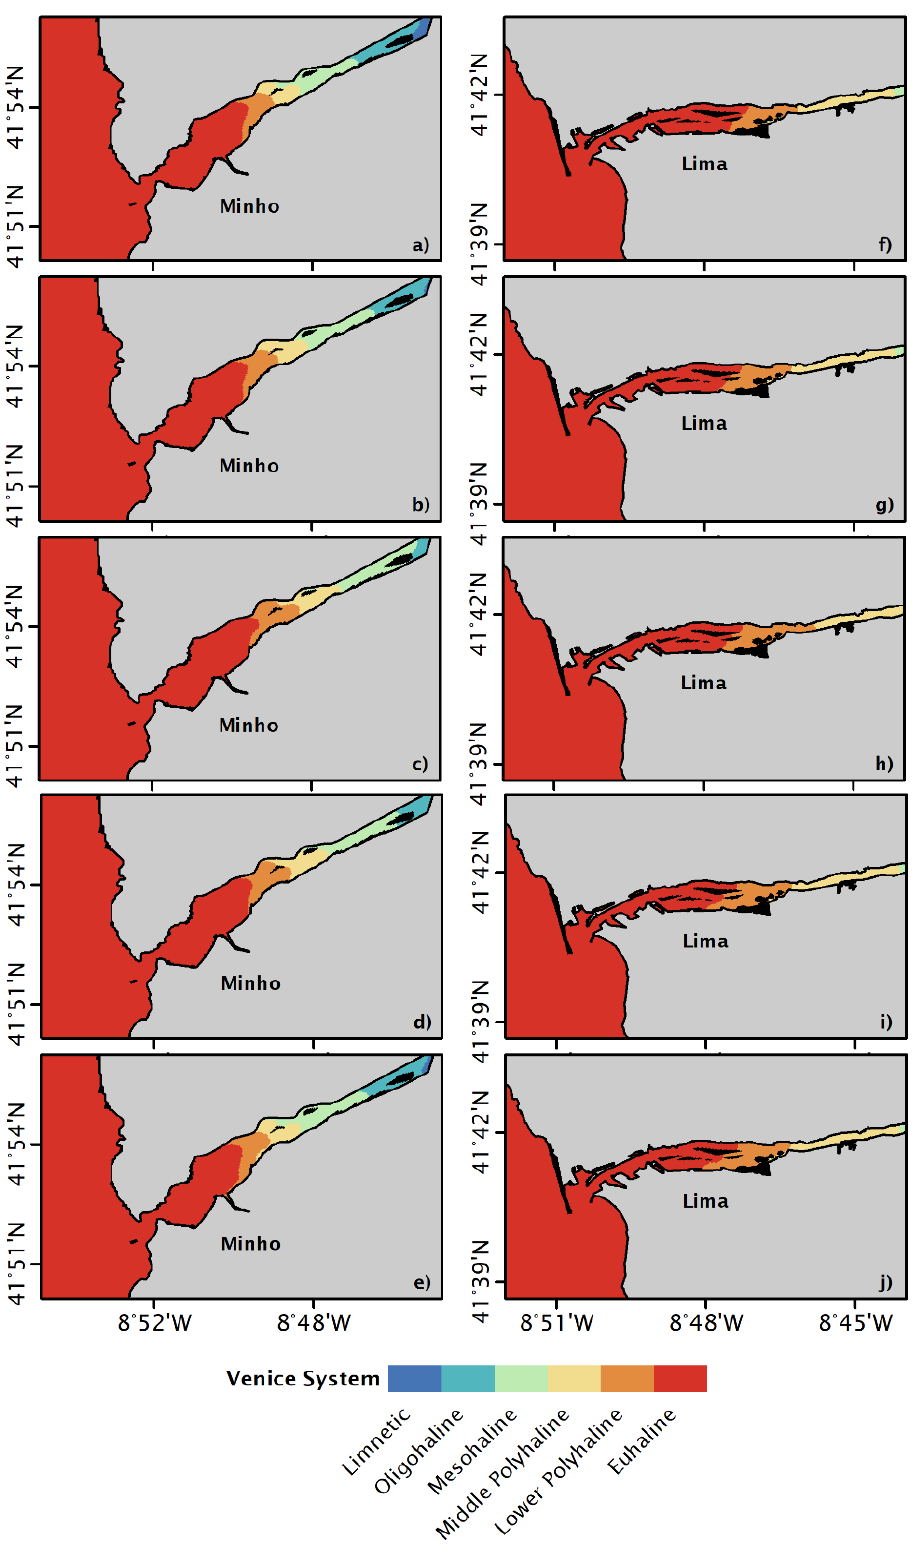
Figure 5. Salinity distribution based on the Venice system during summer conditions for the scenarios Present ( a , f ), RCP 4.5 ( b , g ), RCP 8.5 ( c , h ), RCP 8.5 SL ( d , i ), and RCP 8.5 RD ( e , j ). The left panel represents the Minho estuary and the right panel the Lima estuary.